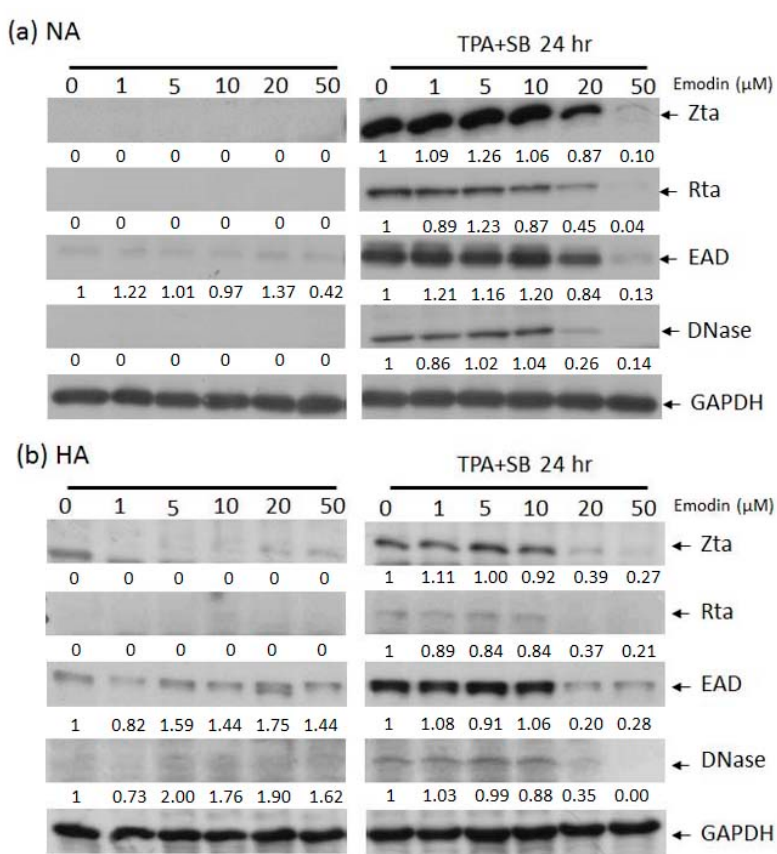
Figure 2. The expression of EBV lytic proteins in epithelial cell lines is inhibited by emodin. Western blot analysis of EBV positive NA ( a ) and HA ( b ) cells treated with emodin alone (left panels) or emodin and TPA + SB (right panels). Zta, Rta, EAD, DNase are EBV lytic proteins, GAPDH serves as a loading control. Forty ng / mL TPA, 3 mM SB, and 1 to 50 µ M emodin were used in this experiment.